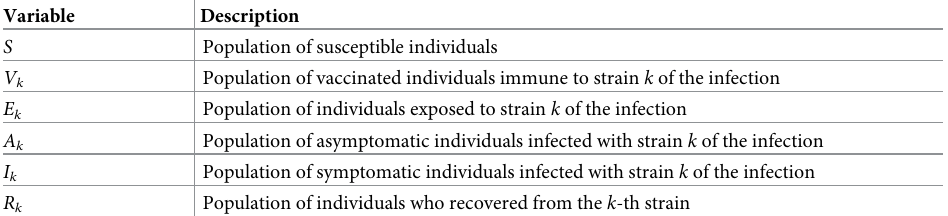
Table 1. Description of variables for the epidemic model.